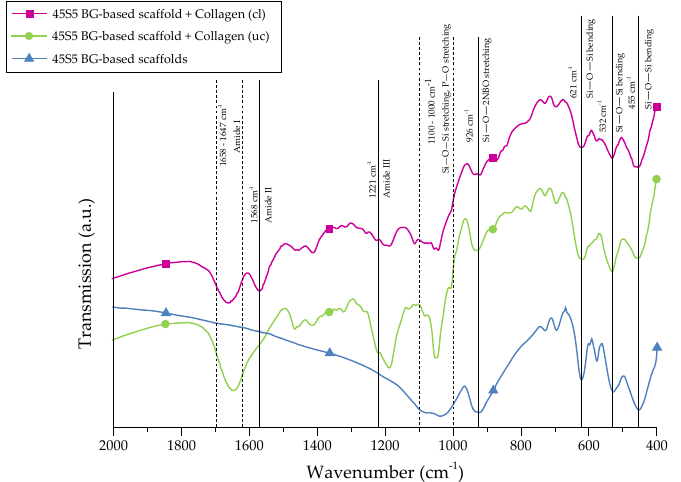
Figure 4. FTIR spectra of 45S5 BG-based scaffolds and collagen-coated 45S5 BG-based scaffolds before and after crosslinking. Relevant peaks are discussed in the text.